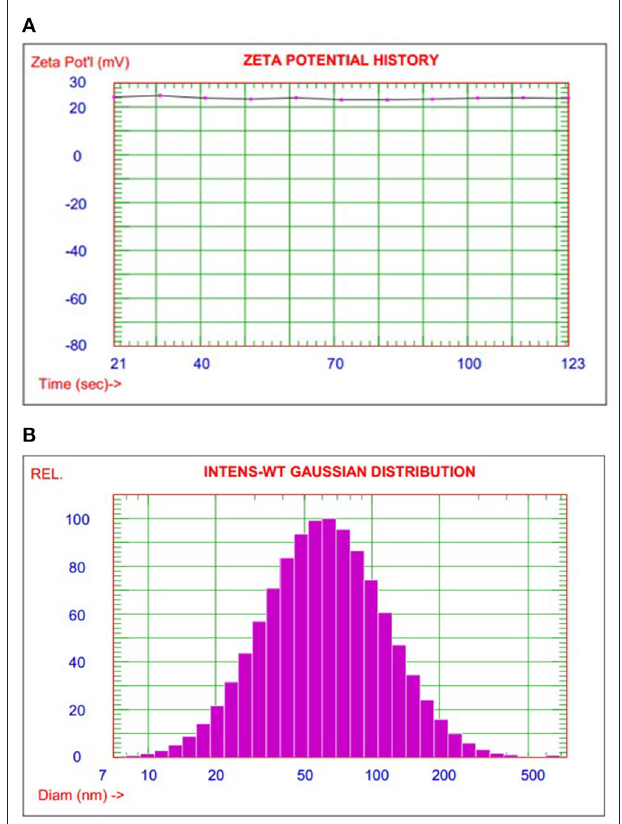
FIGURE 1 | (A) The particle size distribution and zeta potential measurement for nanoencapsulated smart polymer composites. (B) Illustrated the relation of pH value with the color change of smart package